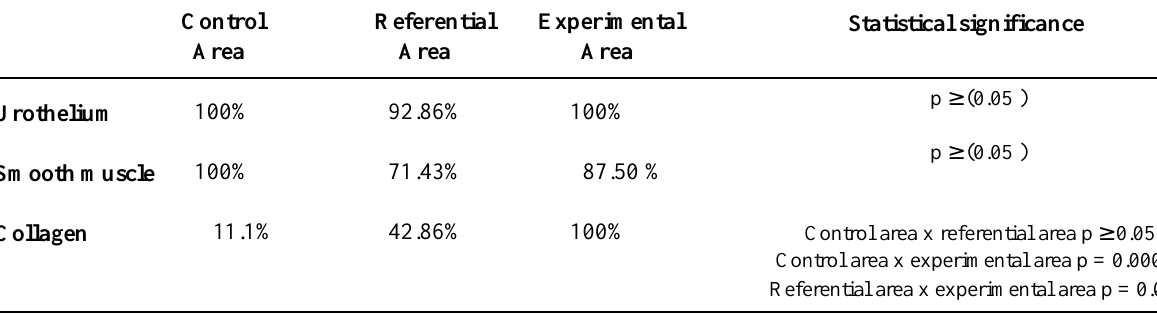
Table 2 – Mean diameter of the studied areas. Ureter Left ureter diameter (control ureter) Right proximal diameter Graft site diameter Right distal diameter Left ureter x proximal right ureter Left ureter x graft site in the right ureter Left ureter x distal right ureter Proximal right ureter x graft site Proximal right ureter x distal right ureter Graft site x distal right ureter * statistically